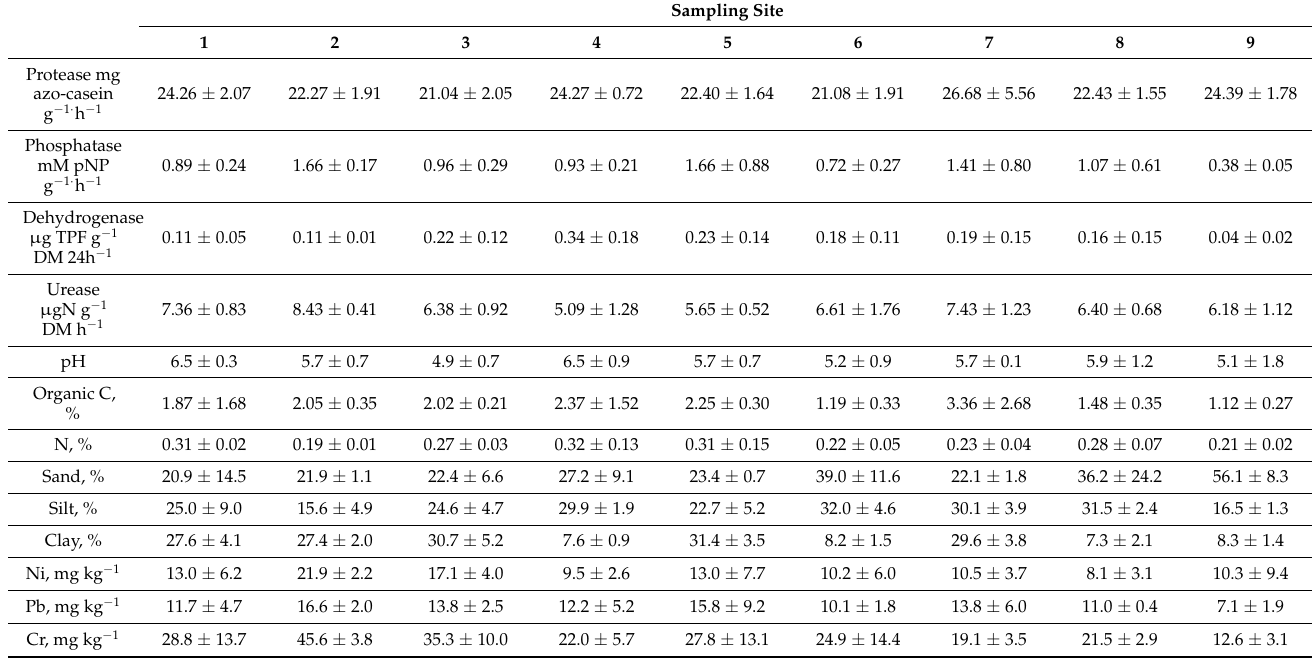
Table 2. Characteristics of studied soils (mean ± standard deviation). Values refer to the average from all sampling